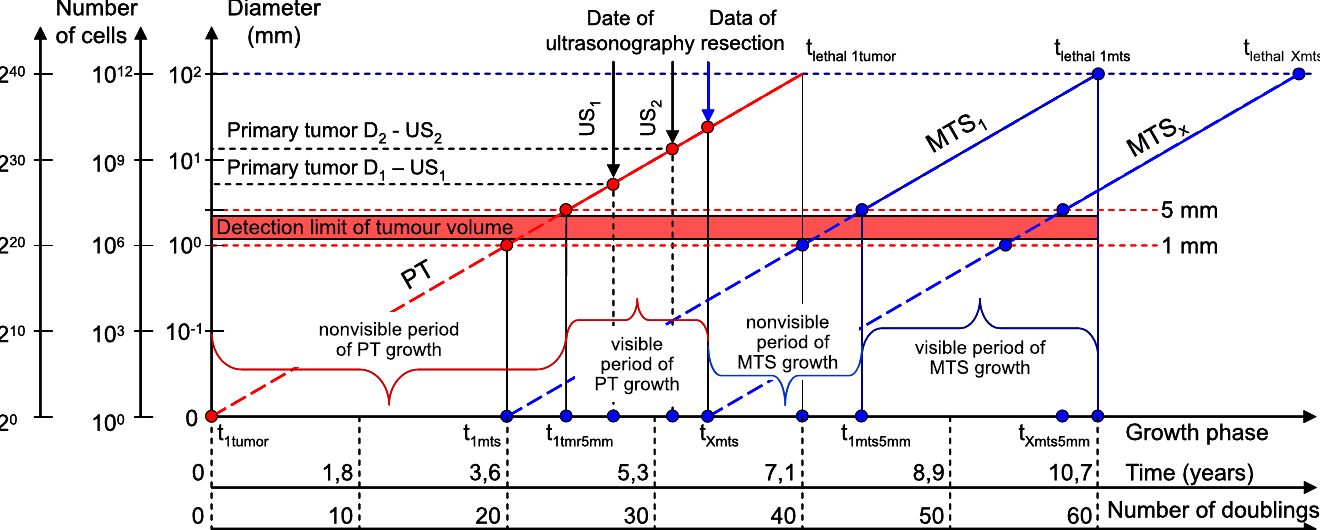
Fig 1. The whole natural growth history of PT and secondary distant MTS includes: The non-visible period of PT growth, the visible period of PT growth, the non- visible period of secondary distant MTS growth, the visible period of secondary distant MTS growth. Ordinate (Y): Diameter of tumor (mm). Abscissa (X): Time (years). t 1tmr − date of appearance of the first BC stem cell; t 1tmr5mm − the date of appearance of the visible PT with size 5 mm; t lethal1tumor − the date of appearance of the lethal PT with size 100 mm (when PT reaches the threshold volume); t 1mts − the date of appearance of the first MTS cancer stem cell that coincides with the period of 20 th doubling time; t 1mts5mm − the date of appearance the first visible MTS of BC with size 5 mm; t lethal1mts − the date of appearance the first lethal MTS of BC with size 100 mm (when secondary distant MTS reached the threshold volume); t Xmts − the date of appearance nXmts cell of BC MTS that coincides with date of operation; t Xmts5mm − the date of appearance nXmts visible BC MTS with size 5 mm; t lethalXmts − the date of appearance nXmts lethal BC MTS with size 100 mm; US 1 –the date and sizes of the first US of PT; US2 –the date and sizes of the second US of PT.